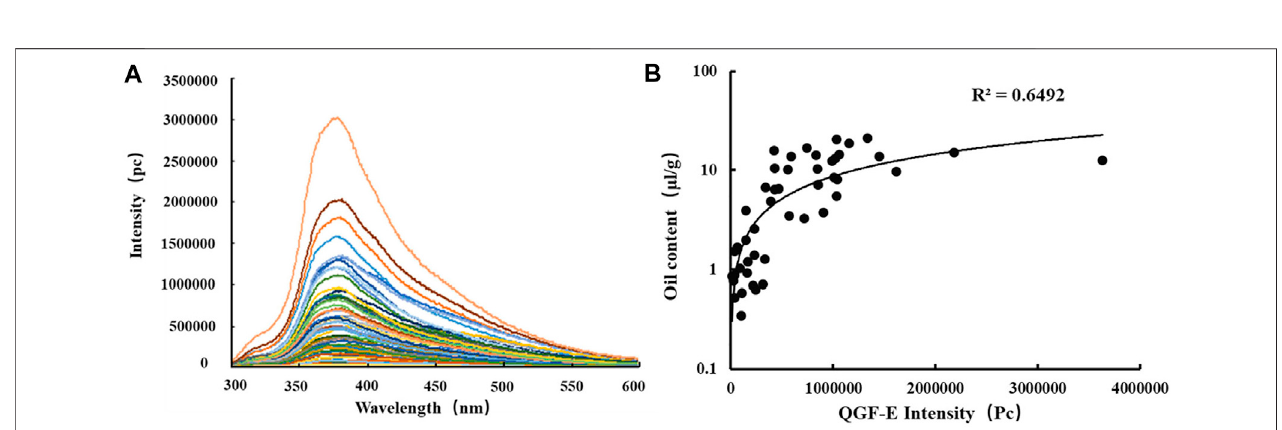
FIGURE 10 | (A) QGF-E analysis; (B) Relationship between oil content and QGF-E intensity.